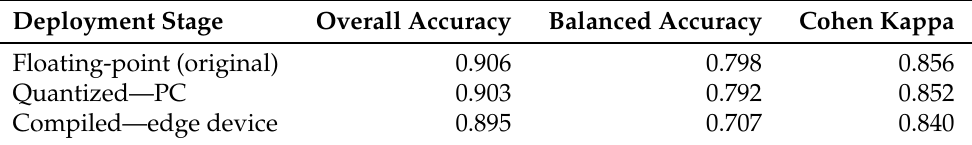
Table 7. The change of metrics across the different stages of Deep Mars